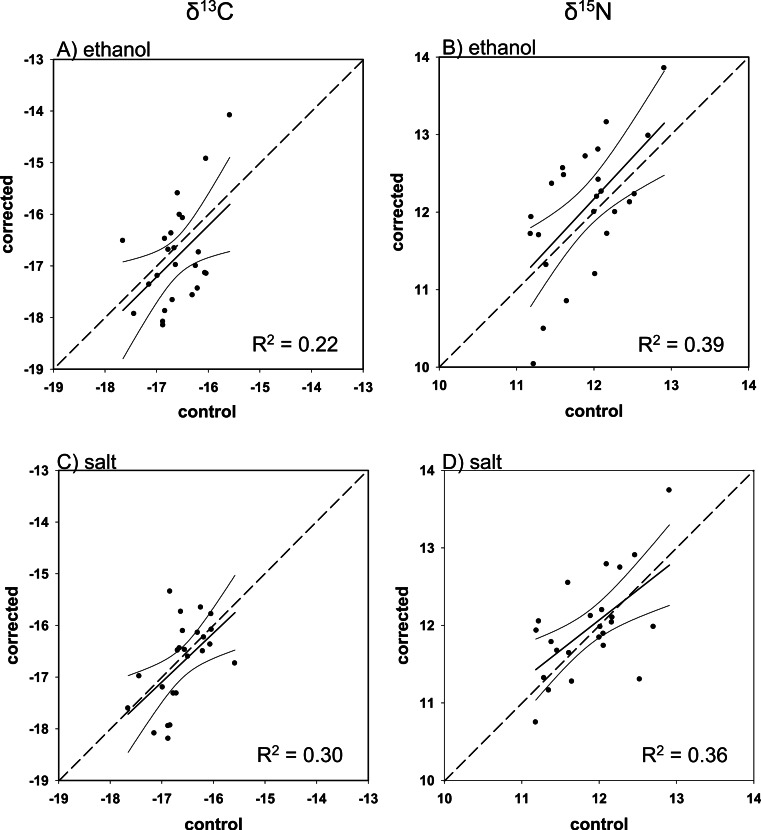
Mass balance corrected values against control values for E. morio.The 1:1 line (hashed), predicted (solid), and 95% confidence intervals are given for (A) ethanol δ13C, (B) ethanol δ15N, (C) salt δ13C, and (D) salt δ15N.